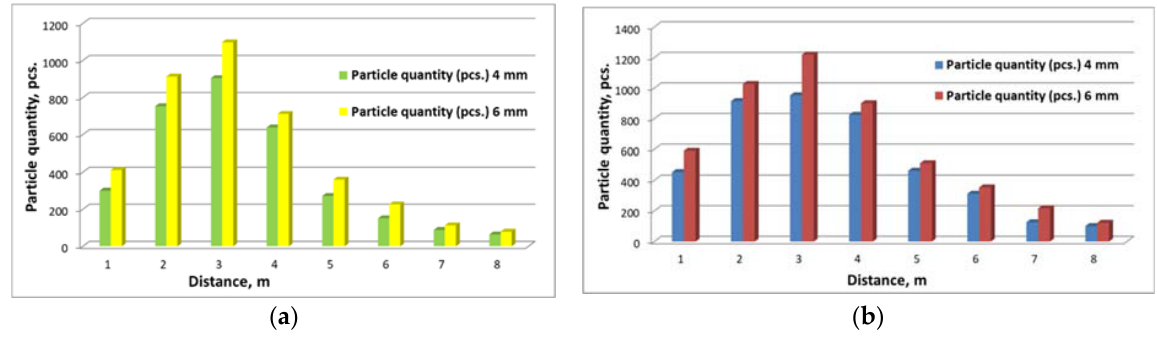
Figure 9. Spreading of fertilizer granules obtained at a disc rotation speed of 450 min − 1 : ( a ) normal discharge flow rate of 200 g s − 1 ; ( b ) normal discharge flow rate of 400 g s − 1 .